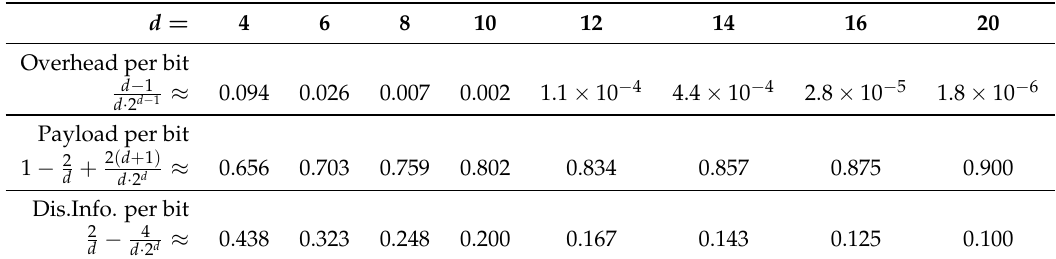
Table 1. The payload, disambiguation information, and overhead bits per each original bit introduced by the proposed non-UD coding for some selected d